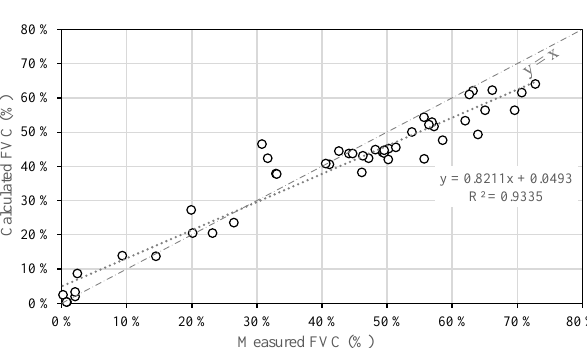
Table 1. Selected metrics for presenting ecosystem dynamics. Components Metrics Description Regions with detectable water distribution, including inundated river Spatial extent channels, ponds and terminal lakes. Water Number of times a pixel is distributed with water for a specific period and Frequency index divided by the length of the period; Thomas et al. (2011). Vegetation (overall/100, Spatial extent Regions with detectable vegetation distribution. Number of times a pixel is distributed with vegetation and divided by Frequency index the length of the period. The fraction of green vegetation within a pixel.